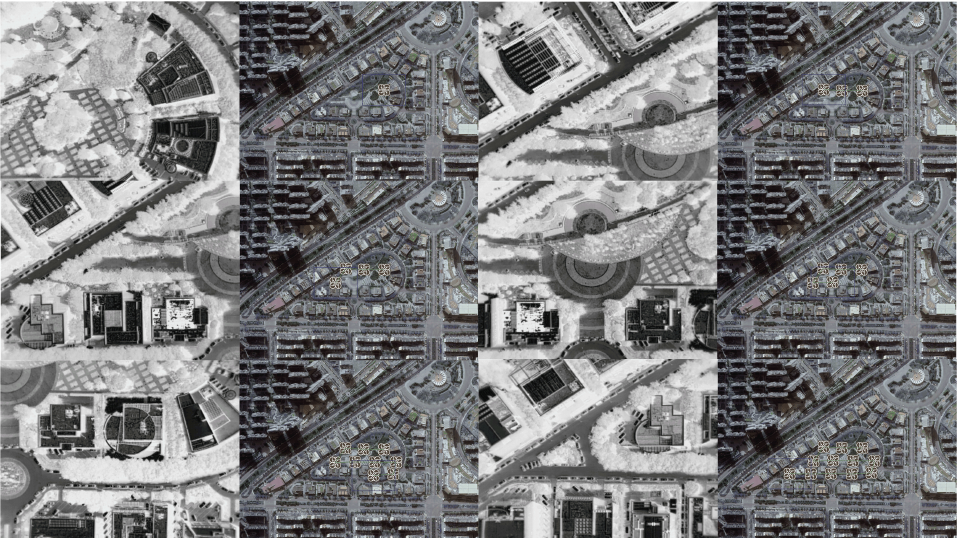
Figure 15. The UAV trajectory tracking results of our